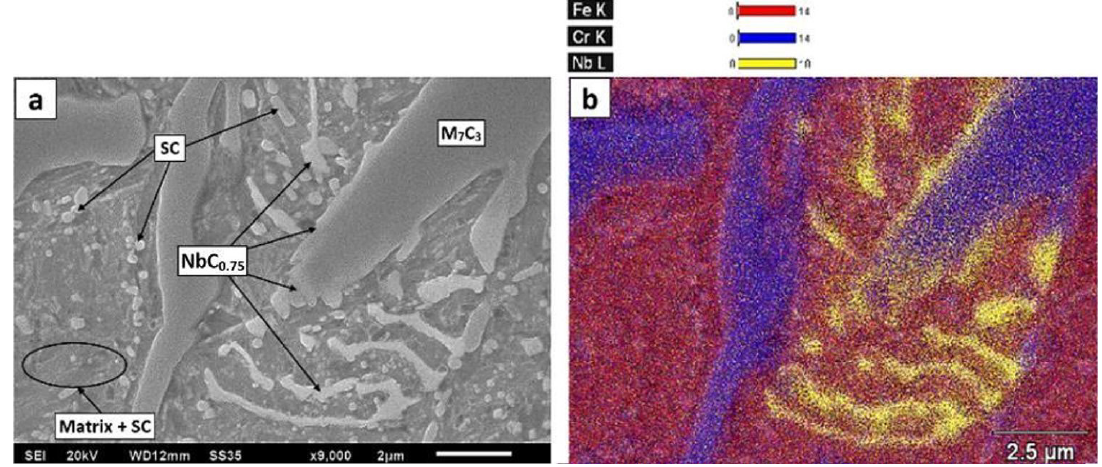
Figure 5. Microstructure of the HCCI0.5%Nb alloy (a) SEM; and (b) chemical mapping.